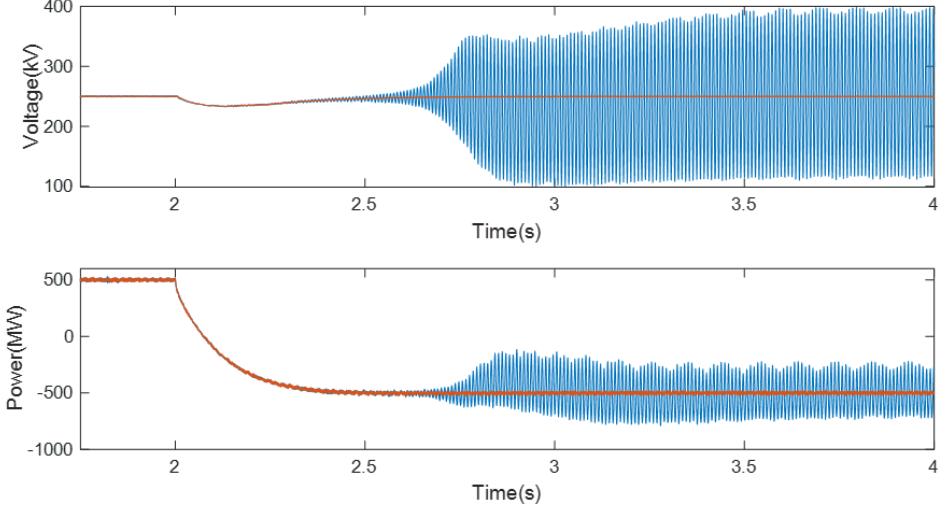
Figure 15. DC-link voltage and active power of the VSC – HVDC system under different DC side capacity.